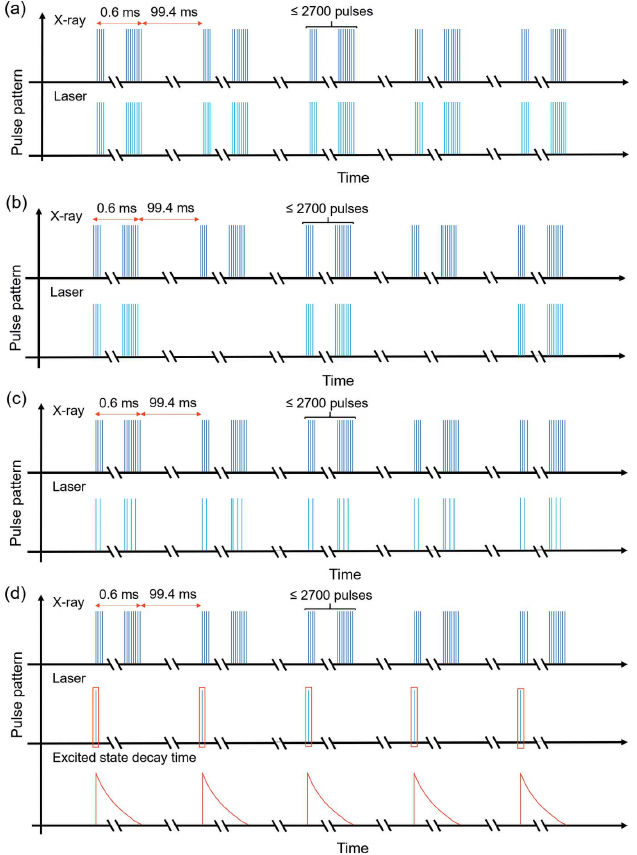
Figure 5 Several examples of pulse pattern setting for optical laser pulses. ( a ) Pump and probe source have the same pulse pattern. ( b ) Burst-mode operation where the optical laser pulses are down picked for so-called light and dark states for consecutive trains. ( c ) Burst-mode excitation with an arbitrary intra-train pulse pattern derived from a megahertz X-ray pulse pattern. ( d ) 10 Hz pump and sampling with a megahertz X-ray pulse pattern.